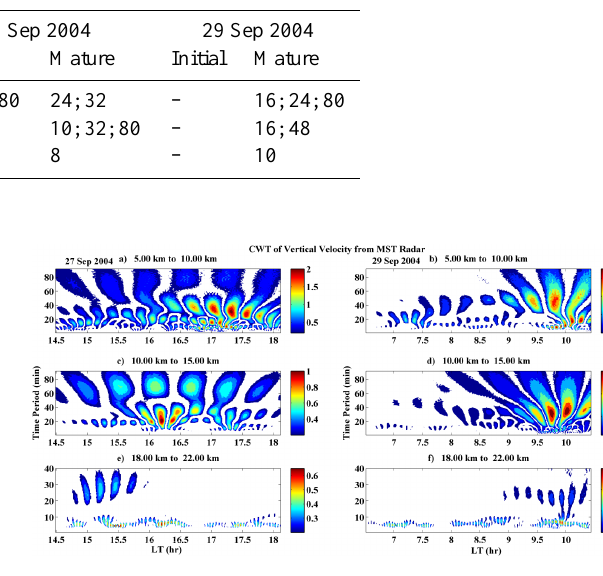
Figure 6B. Same as Figure 6A during convection. 702 Fig. 6b. Same as Fig. 6a during convection.